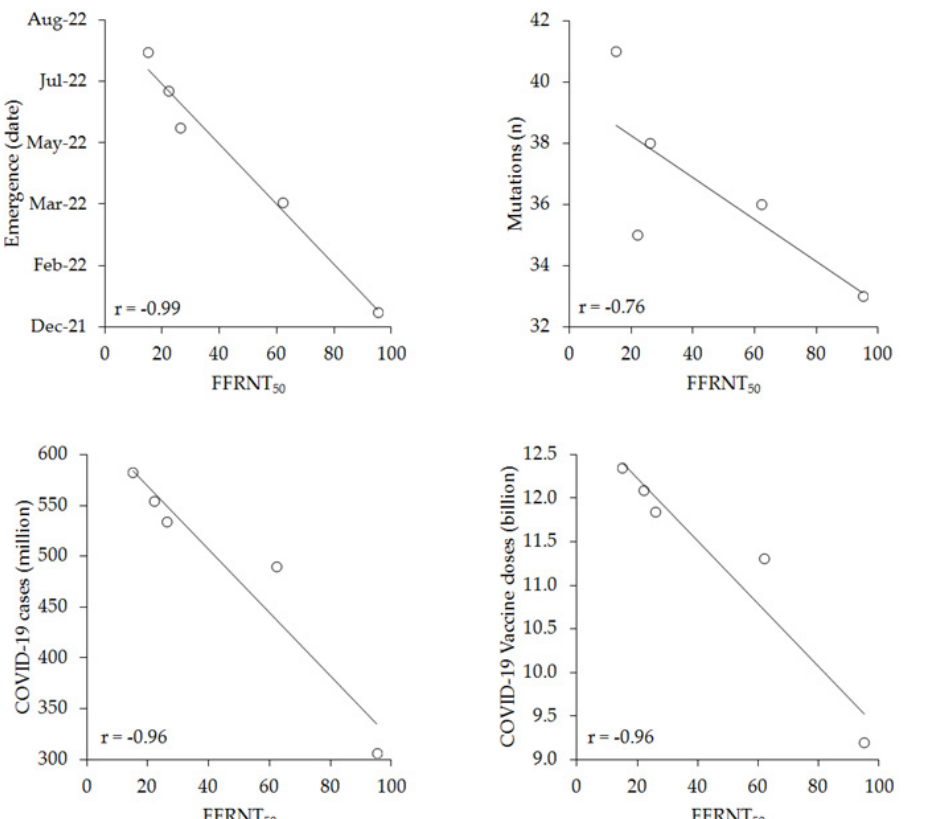
Figure 1. Univariate (Spearman’s) correlations between the FFRNT 50 value for different SARS-CoV-2 Omicron sublineages in recipients of four doses of monovalent mRNA-based COVID-19 vaccines; date of emergence and number of spike protein mutations of the sublineages; cumulative worldwide COVID-19 cases; and cumulative number of COVID-19 vaccine doses administered worldwide at the time of SARS-CoV-2 Omicron sublineage emergence. Table 2. Univariate (Spearman’s) and multivariate (multiple linear) correlations between FFRNT 50 value for different SARS-CoV-2 Omicron sublineages in recipients of four doses of monovalent mRNA-based COVID-19 vaccines; date of emergence and number of spike protein mutations of the sublineages; cumulative worldwide COVID-19 cases; and cumulative number of COVID-19 vaccine doses administered worldwide at the time of SARS-CoV-2 Omicron sublineage emergence.